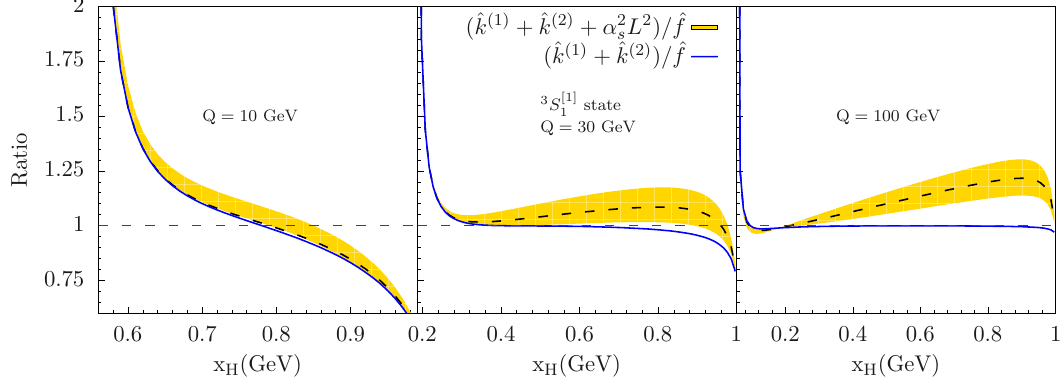
channel at CM energies 1